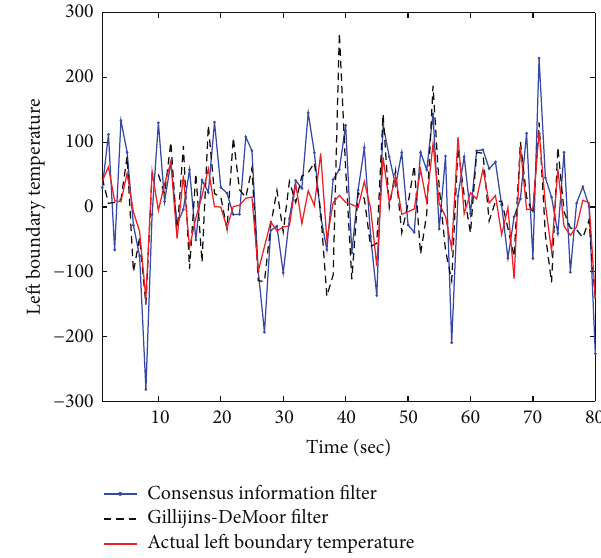
Figure 5: The left boundary